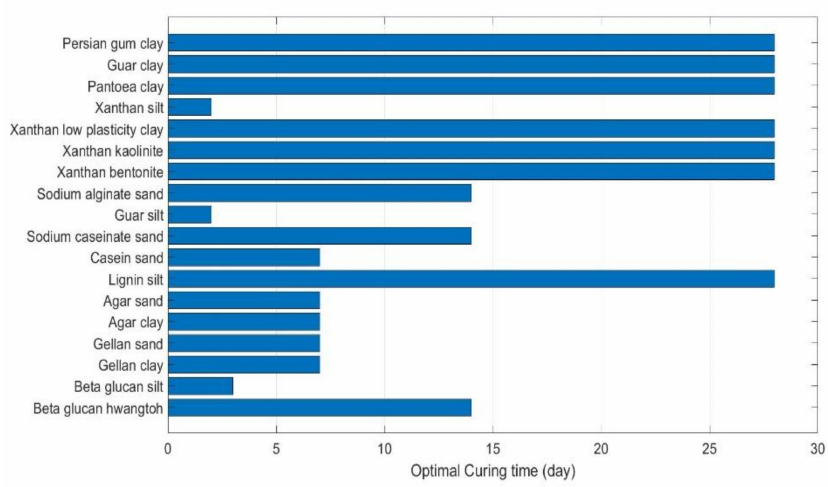
Figure 13. Optimal time required for each biopolymer-treated soil [58,62,66,82,111,115,130,133,138,